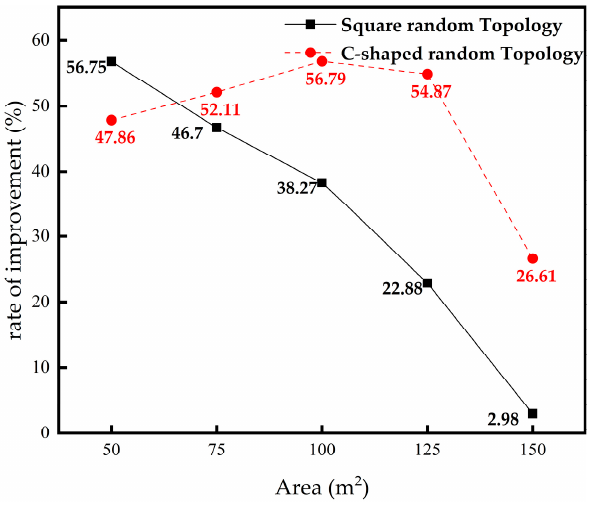
Figure 11. Comparison of localization error improvement in di ff erent Area.